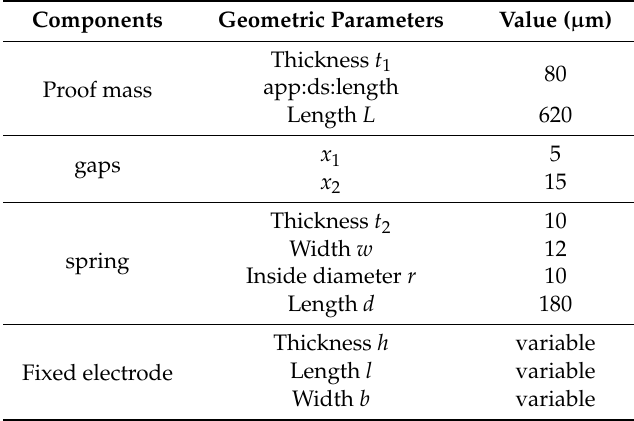
Figure 3. Three-dimensional view of the micro-switch ( a ) in sample 1 and ( b ) in sample 2; 2D sketch of the stationary electrode ( c ) in sample 1 and ( d ) in sample 2; ( e ) top view of the whole structure; and ( f ) side view of one-half structure. Table 1. Main geometric parameters of the designed device .